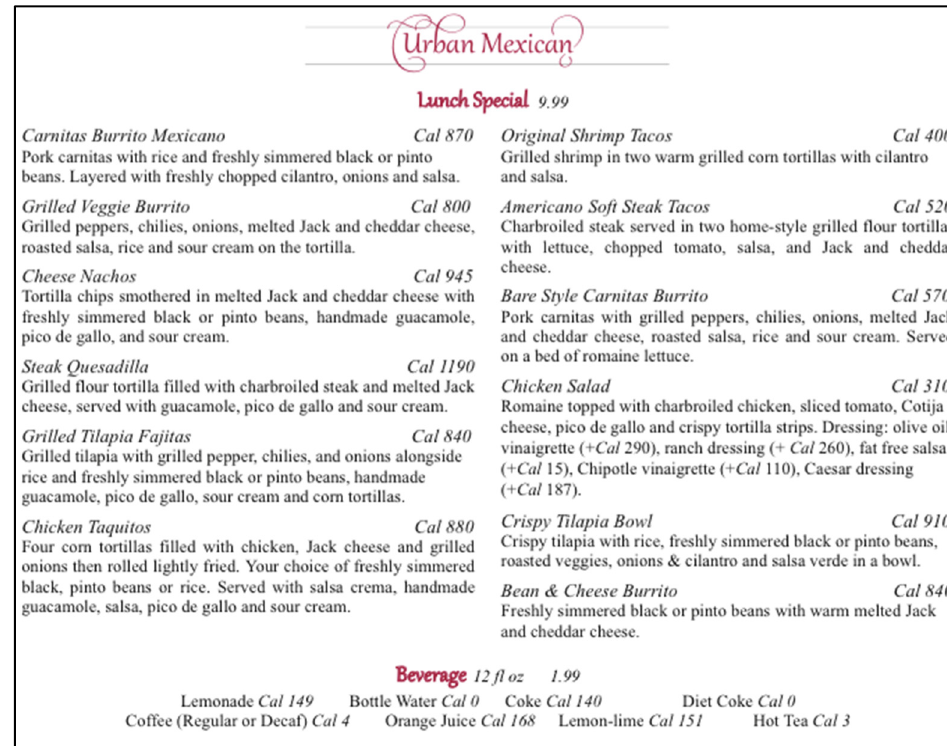
Figure A10. Urban Mexican First and Last Menu.